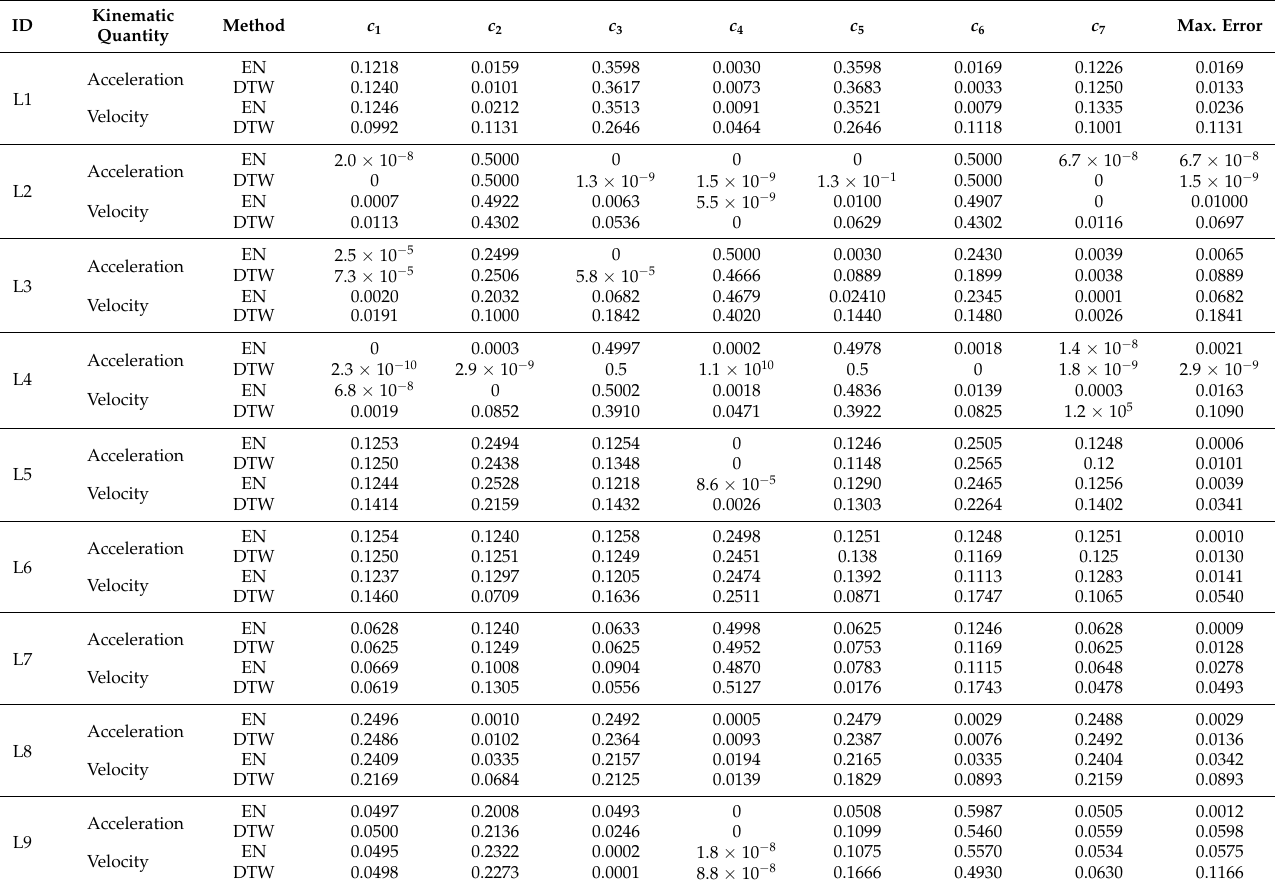
Table 4. Identified coefficients’ values (dimensionless) and errors in the simulated cases with laws of motion of the modified trapezoidal class used as the original law of motion. (The method column refers to the method used to calculate the objective